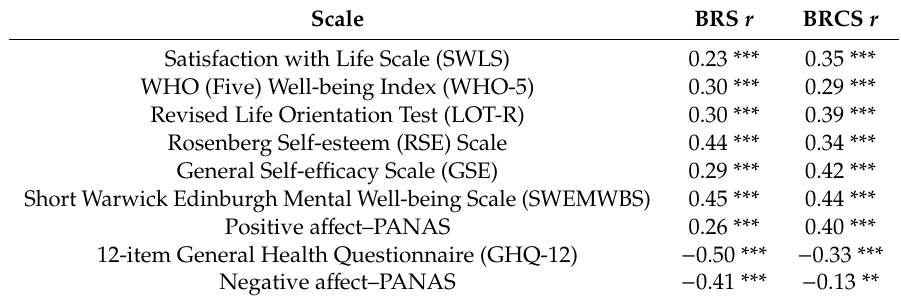
Table 2. Pearson correlations between the BRS and BRCS compared with other well-established scales. Scale BRS r BRCS r Satisfaction with Life Scale (SWLS) 0.23 *** 0.35 *** WHO (Five) Well-being Index (WHO-5) 0.30